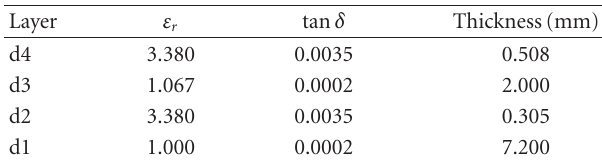
Table 1: Dielectric